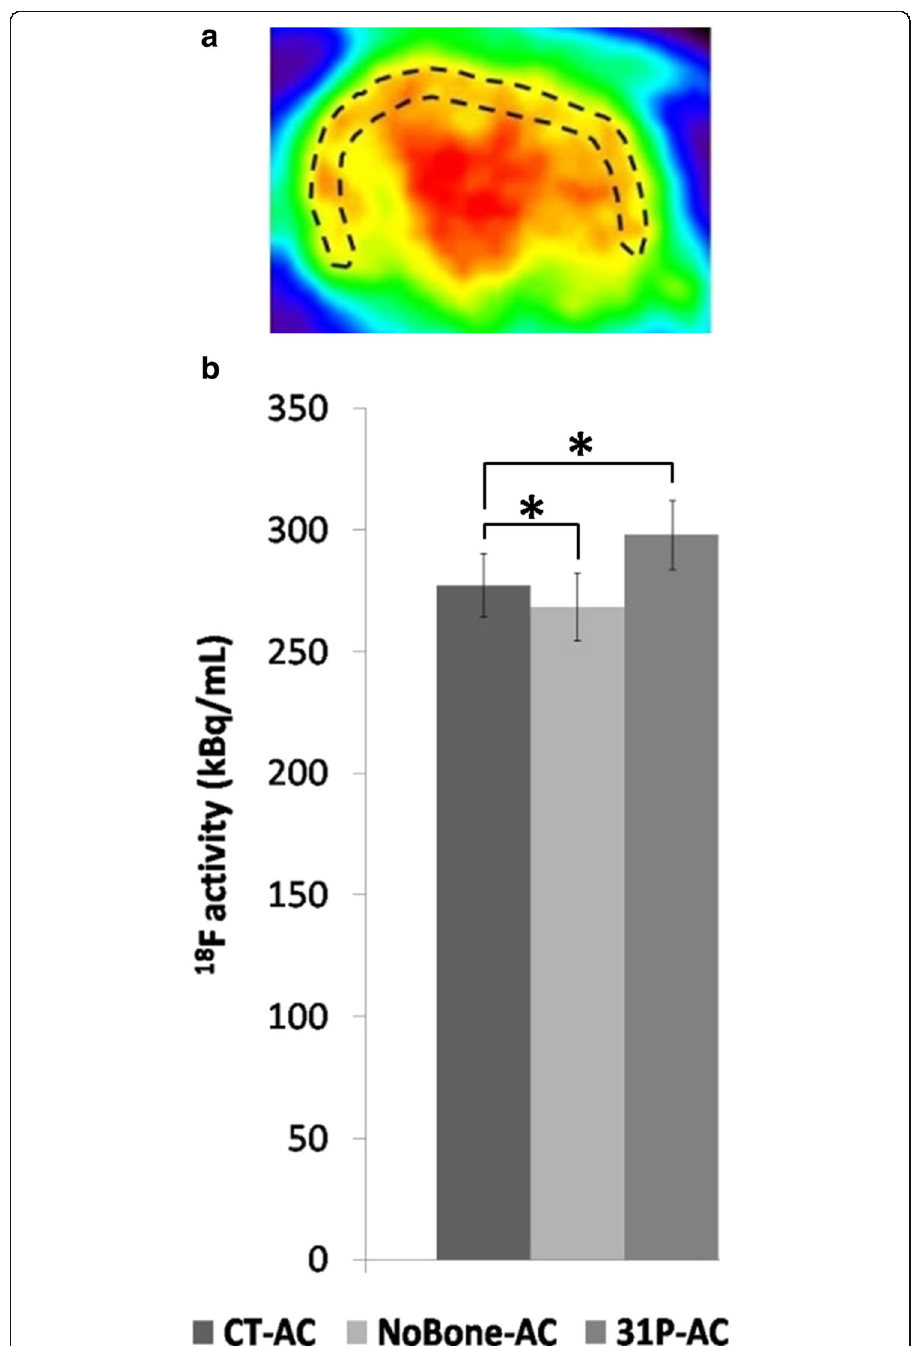
Fig. 5 Peripheral brain ROI ( a ) in which 18 F activity was measured for the three different attenuation corrections ( b ). * p <